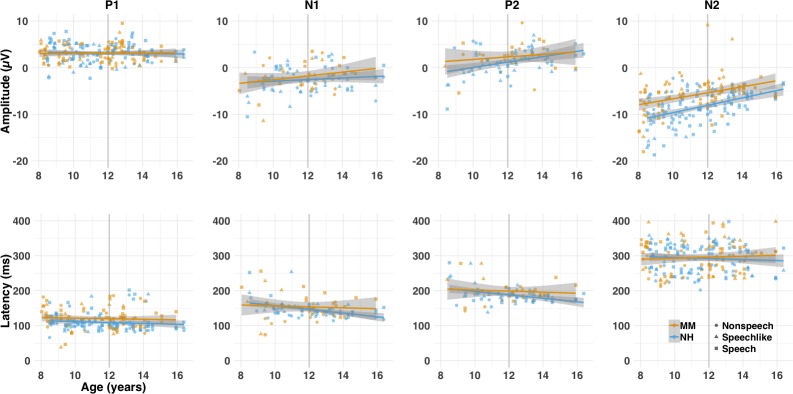
Amplitude (μV) and latency (ms) of the LAER components (P1, N1, P2, and N2), where present, for each group (MM vs. NH) as a function of age (cross-sectional study).Individual (shapes) and group (lines) data are shown for each condition (nonspeech = circles; speech-like = triangles, speech = squares) and component for the MM (orange) and NH (blue) groups. Shaded lines represent the 95% confidence interval. For illustrative purposes, age is represented as a continuous variable, but was treated as a categorical variable (Y vs. O in the analyses, see main text). The grey vertical lines on each subplot represent the median age split into the Y (left of the line) and O (right of the line) age bands. Across ages and conditions, children with MMHL on average shoed P1s and P2s that were later than, and N2s that were smaller than, those of their NH peers, where these components were present.